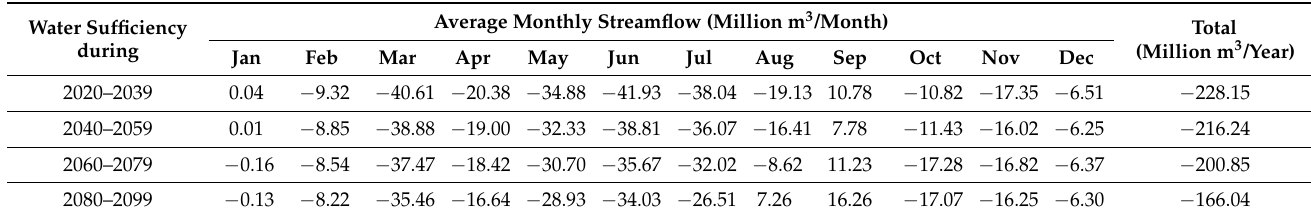
Table 7. Water sufficiency for agriculture in the Lam Takong River Basin under RCP 4.5.